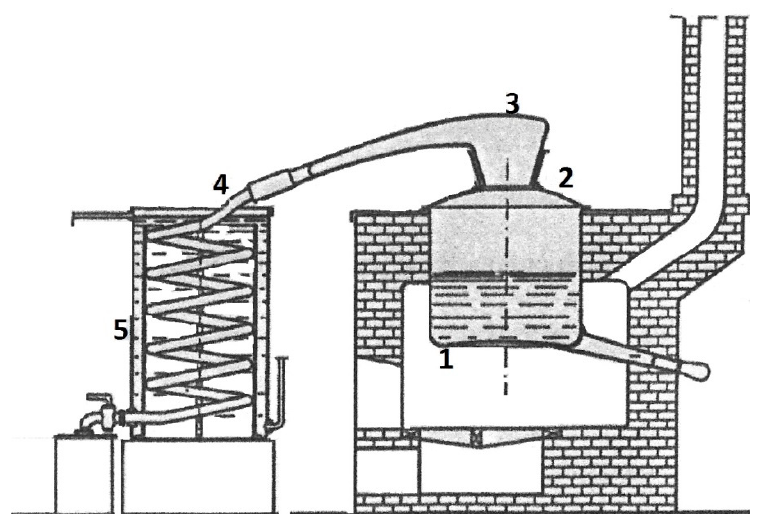
Figure 1. A typical pot still used for batch distillation of spirits. 1 : Tinned copper pot; 2 : still head; 3 : swan’s neck; 4 : copper coil; and, 5 : water cooling tank.